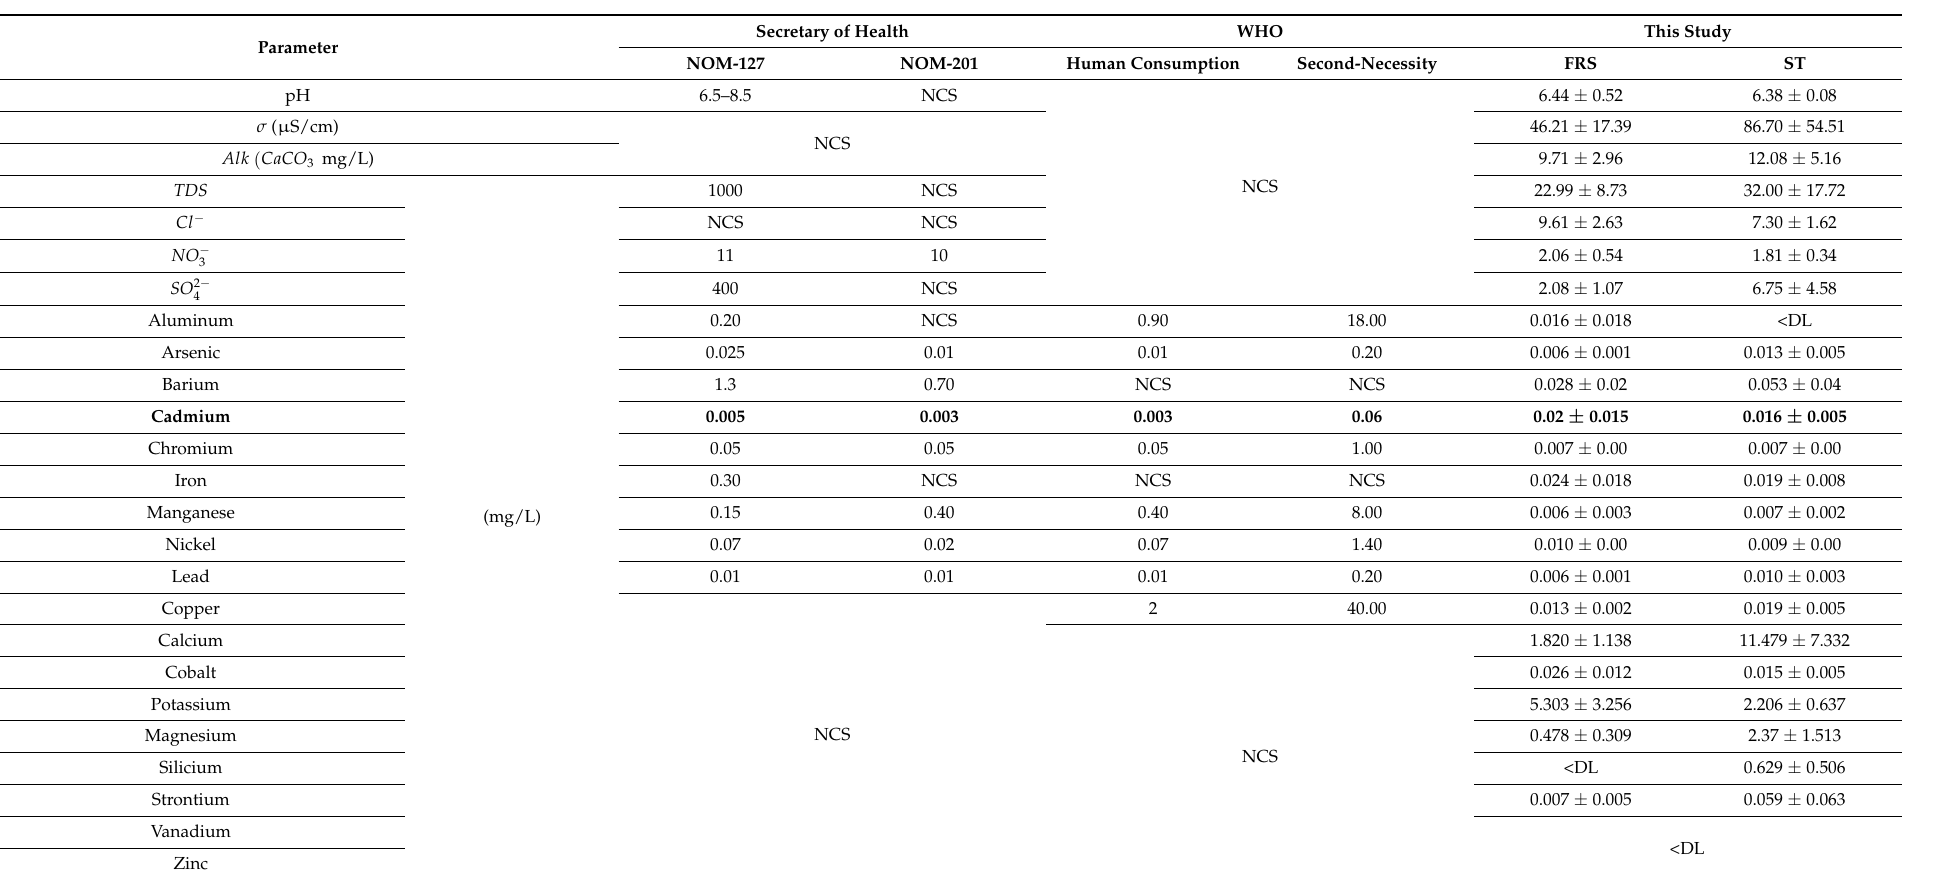
Table 2. Quality of collected water compared to the parameters for different uses according to the World Health Organization and the Ministry of Health through the standards: NOM-127-SSA1-2021 and